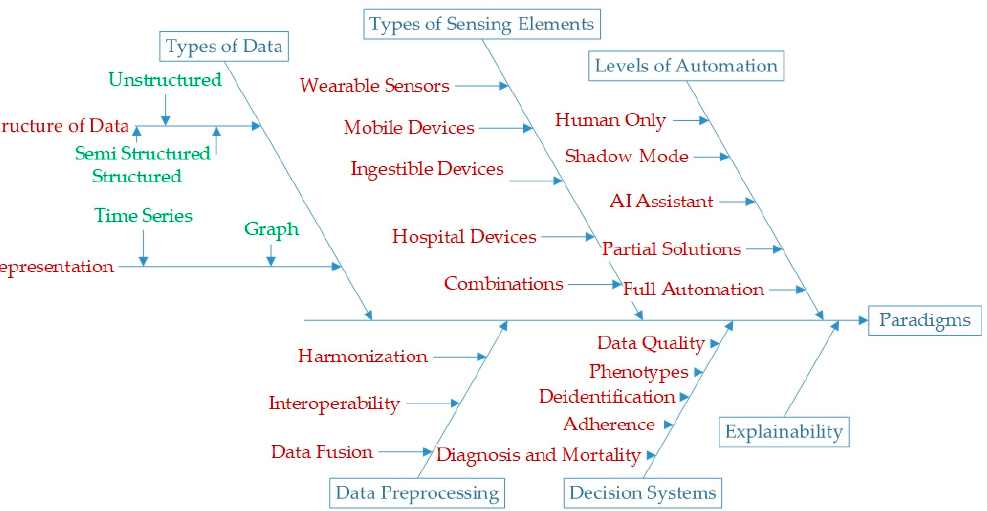
Figure 2. Ishikawa Fishbone diagram of the paradigms.